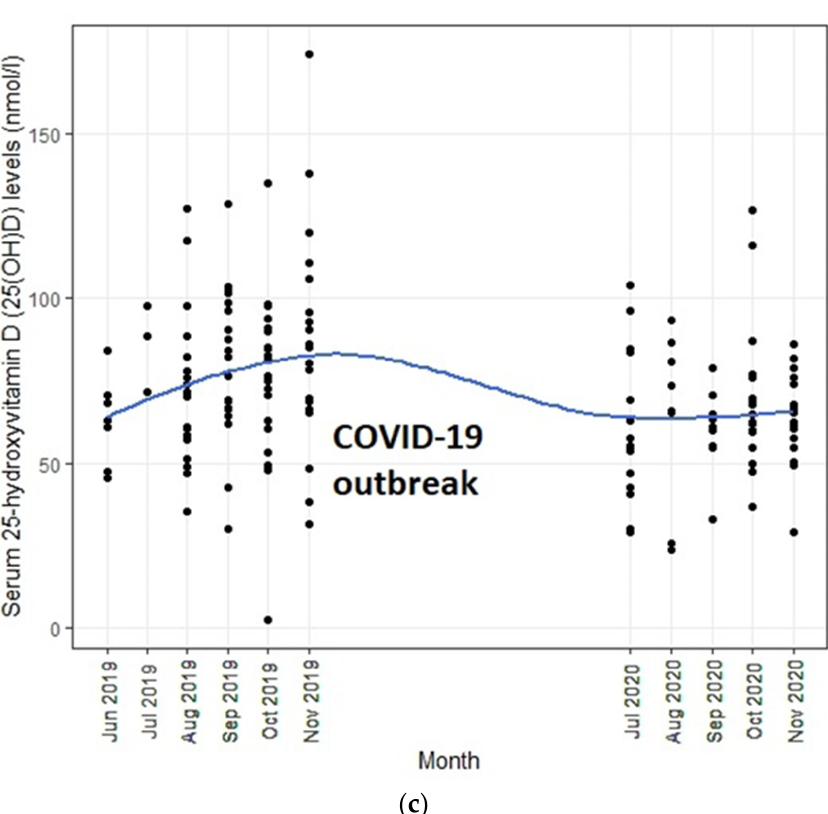
Figure 1. Serum 25(OH)D levels in infants ( a ) overall; ( b ) aged 2–6 months; ( c ) aged 7–24 months recruited between 1 June 2019 and 30 November 2020.